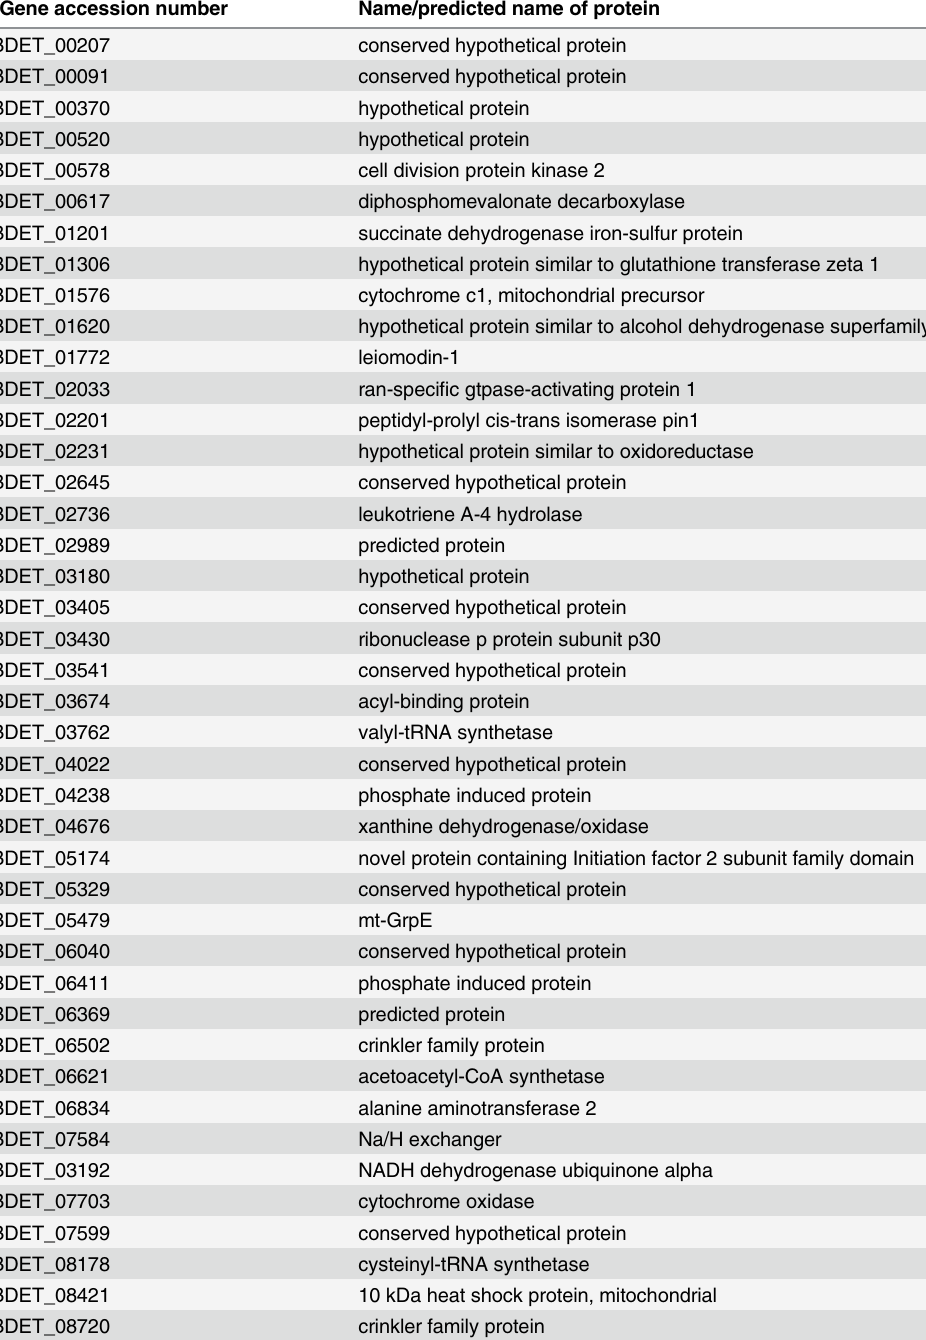
Table 2. List of uniquely present proteins in Bd exposed to T 3